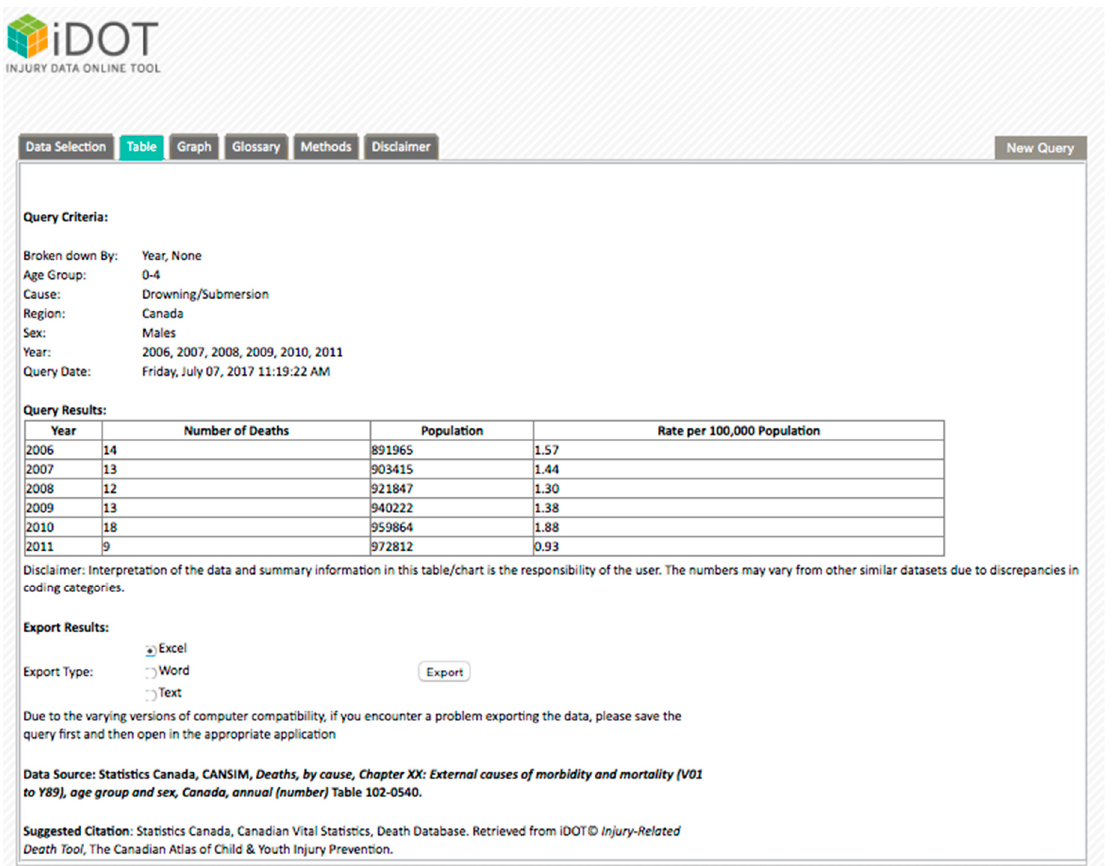
Figure 3. i DOT output in table display.